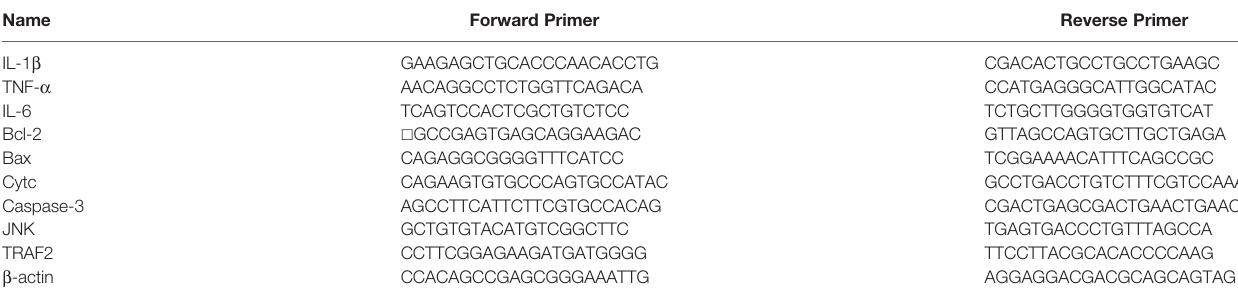
TABLE 1 | Sheep neutrophils primer sequences.